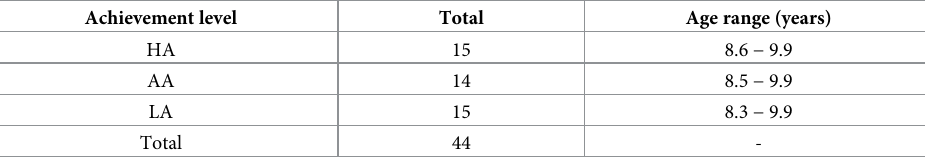
Table 3. Number of participants organized by achievement level after the process of outlier